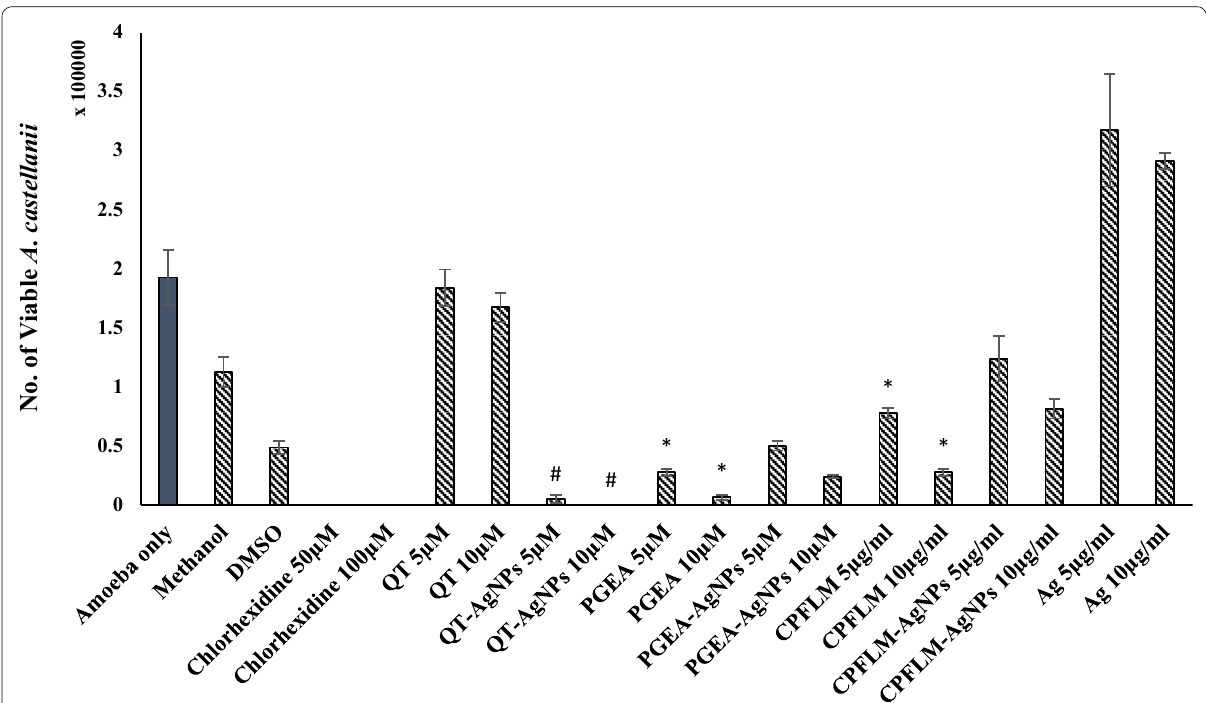
Fig. 6 Effects of QT, PGEA, CPFLM, and the nanoconjugates of natural compounds mentioned above on the excystation inhibition of A. castellanii cysts. 1 10 5 cysts were incubated with 5 and 10 μM (or mg/mL) of natural compounds or nanoconjugates for 72 h at 30 °C then the viability × of A. castellanii trophozoites were determined by staining with 0.1% Trypan blue. The nanoconjugates of quercetin (10 μM) showed significantly increased results as compared to AgNPs and QT alone (#P < 0.05, using two samples T-test, two-tailed distribution). PGEA and CPFLM alone showed significant inhibition of A. castellanii excystation when compared to the negative control (cysts alone) (*P < 0.05, using two samples T-test, two-tailed distribution)